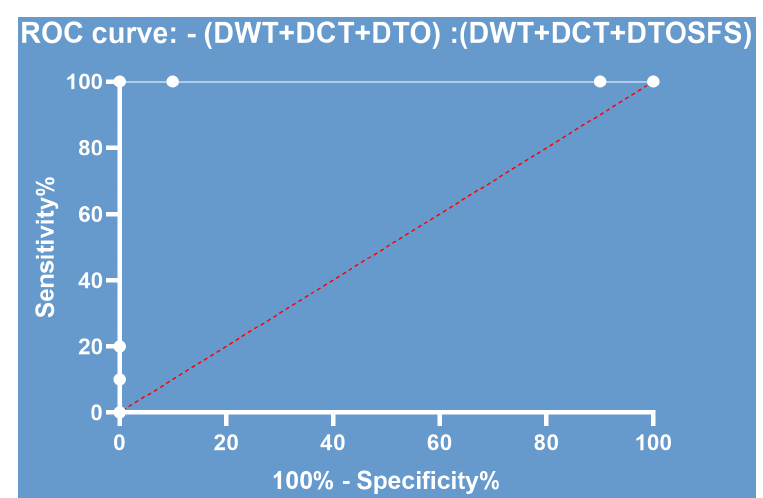
Figure 9. The ROC curve of the results achieved with the proposed approach.